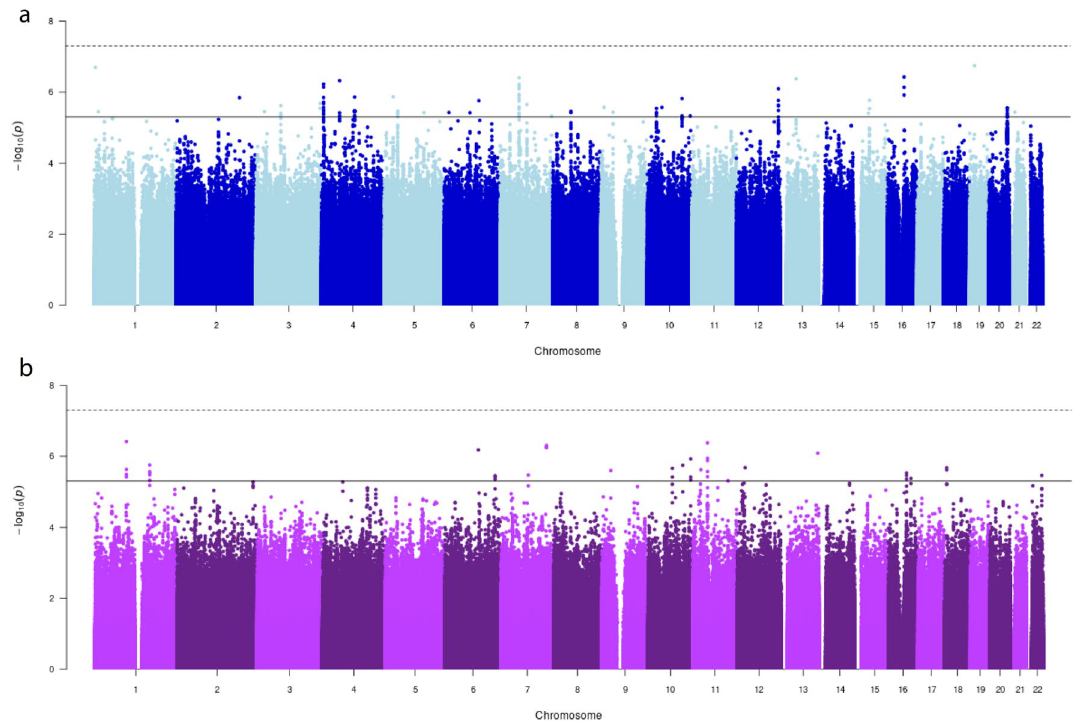
Figure 1. Manhattan plots of step2 GWAS meta-analysis: ( a ) smoking initiation, ( b ) smoking cessation; continuous line, suggestive p-value ( P ) significance threshold (5 × 10 –6 ); dashed line, genome-wide significance threshold (5 × 10 –8 ). Number of participants and variants analysed is reported in Supplementary Fig. 1.